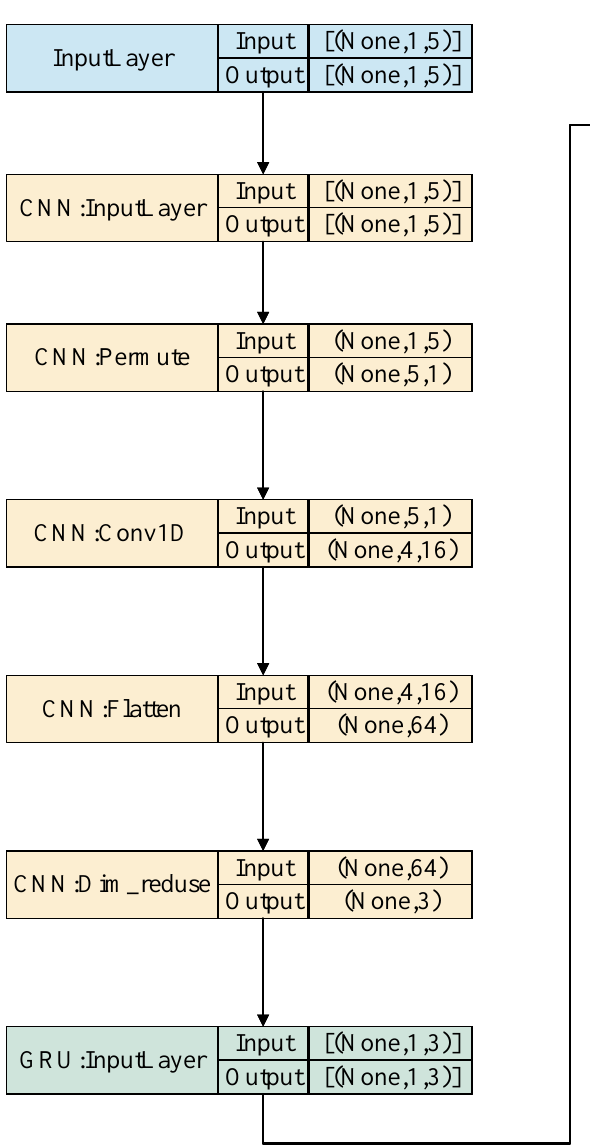
Figure 18. Structural parameters of the